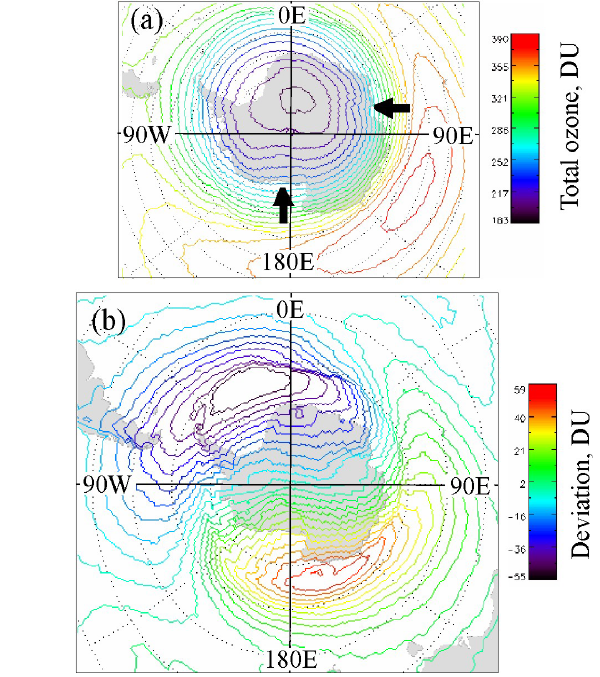
Fig. 7. The 24-year mean distribution of (a) total ozone and (b) its deviation from zonal mean from TOMS data for the springs of 1979–2005. The contour intervals are 10DU and 5DU on plots (a) and (b), respectively.